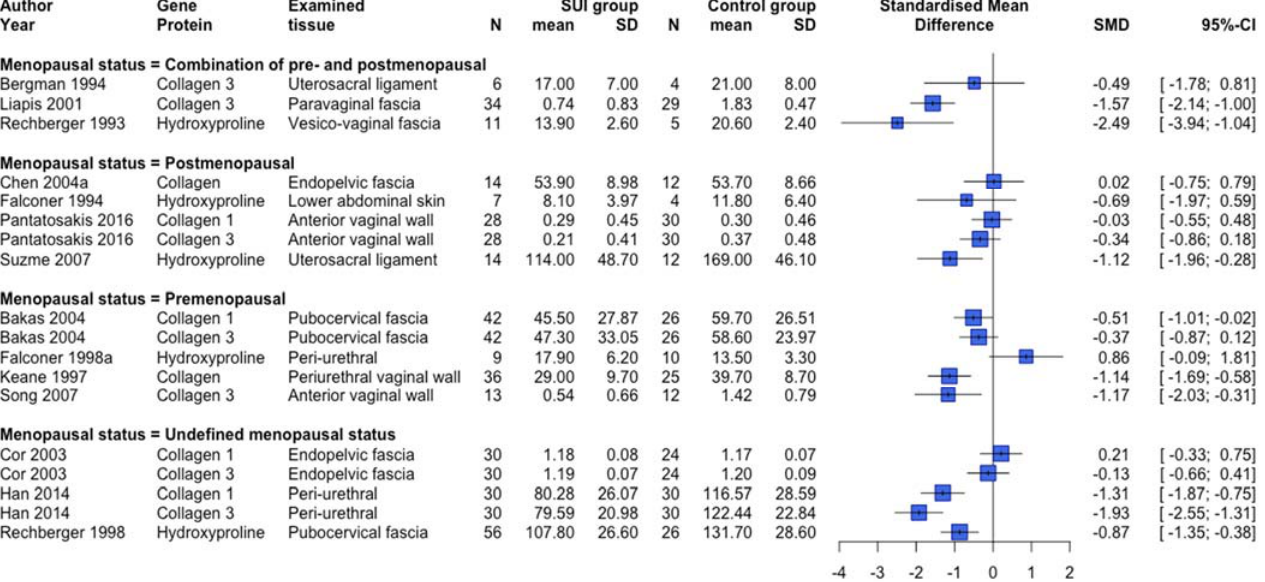
Figure 4. Forest plot of collagen-related protein expression in human studies. This forest plot shows the collagen-related protein expression differences between patients with SUI and controls, subdivided per menopausal status group. Abbreviations: CI confidence interval, N number, SD standard deviation, SMD standardized mean difference, SUI stress urinary incontinence.